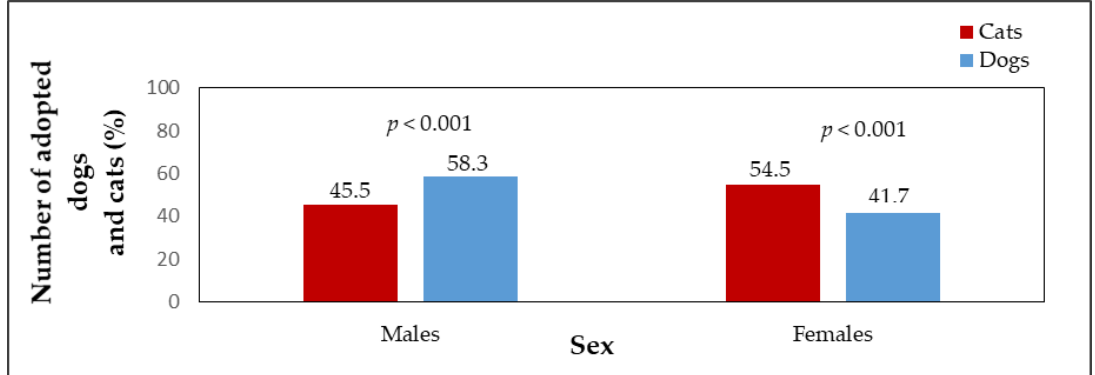
Figure 1. The percentage of adopted dogs (n = 1073) and cats (n = 367) in sex categories.